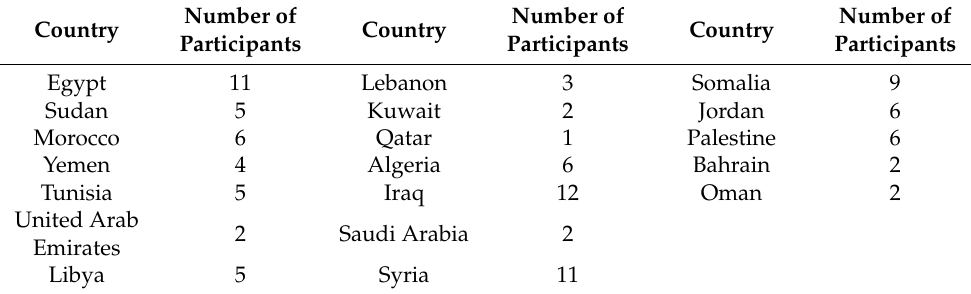
Table 1. Participants’ Arab